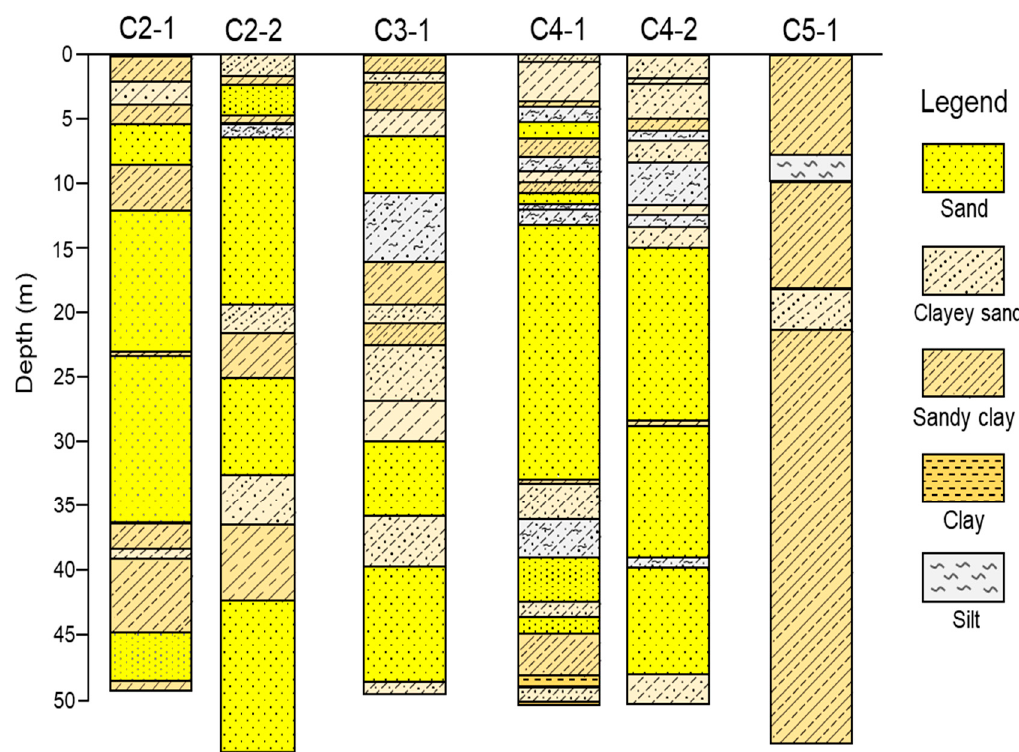
Figure 2. Depositional lithology of typical boreholes in the different